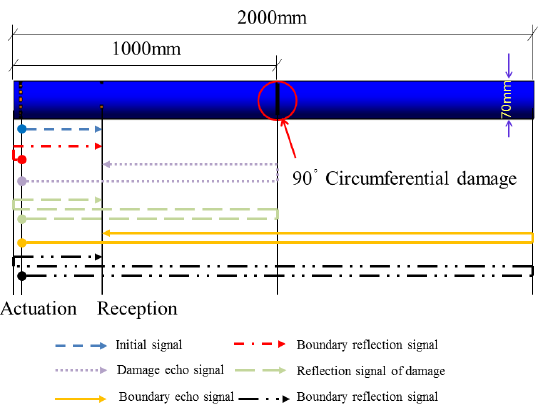
Figure 16. The schematic of signal propagation in the pipe with circumferential damage (90°) in the simulation.